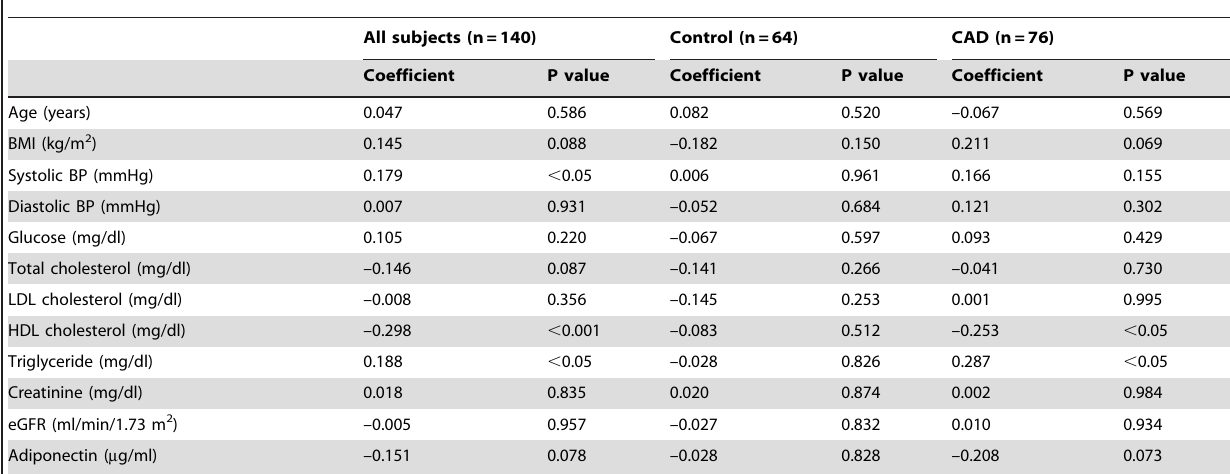
Table 2. Correlation between plasma CTRP1 levels and clinical